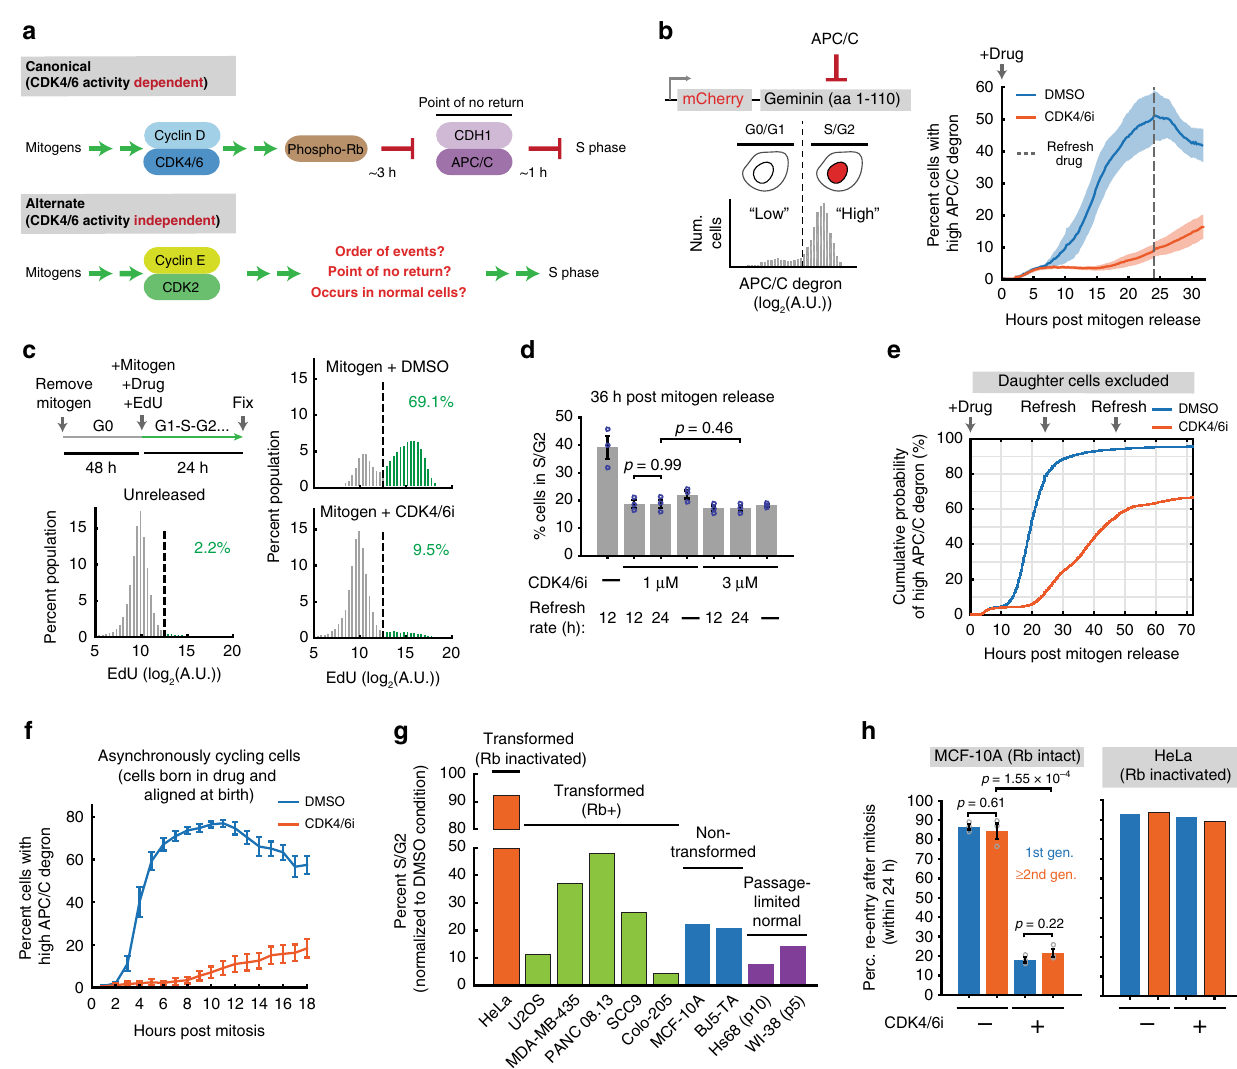
+– Fig. 1 Acute CDK4/6 inhibition reveals a delayed and less ef fi cient cell-cycle entry mechanism. a Two mechanisms of starting the cell cycle. b Left: Degron-based APC/C activity reporter. Right: Mitogen-starved MCF-10A cells expressing the APC/C activity reporter were imaged at the time of mitogen and 1 µ M Palbociclib (CDK4/6 inhibitor) addition. Time points taken every 12 min. CDK4/6 inhibitor refreshed at 24 h. Mean± SEM from fi ve biological replicates. Vertical gray dashed line: time of refreshing drug. c MCF-10A cells mitogen released in the presence of EdU with or without CDK4/6 inhibitor. Cells were fi xed after 24 h (26838, 36549, 29371 cells for unreleased, DMSO, and CDK4/6 inhibitor; 1 of n = 2 biological replicates). d Cells were mitogen released with or without indicated CDK4/6 inhibitor concentrations and the drug was refreshed every 12 h, 24 h, or not at all. Cells fi xed at 36 h after mitogen release. S/G2 cells determined via EdU incorporation and DNA content. Mean ± SEM from three biological replicates; p values calculated using two-sided, two-sample t tests. e CDF of mitogen-released cells inactivating APC/C CDH1 . Only cells present at the time of mitogen release are tracked. n = 7521 and 9563 cells for DMSO and CDK4/6i, respectively. f Percent cells with inactivated APC/C in cells born into DMSO or CDK4/6 inhibitor. Cells aligned at birth. Mean± SEM from fi ve biological replicates. g Different cell lines treated with 1 µ M CDK4/6 inhibitor for 48 h and refreshed at 24 h. Percent S/G2 de fi ned as >2 n DNA (determined by Hoechst) and high endogenous geminin (an APC/C CDH1 substrate). Percentages normalized to the DMSO- treated condition. h Generation comparison of cell-cycle re-entry percentages in MCF-10A (Rb intact) and HeLa (Rb inactivated) cells (MCF10A: mean ± SEM from three biological replicates; p values calculated using two-sided, two-sample t when cells enter mitosis. Starting live-cell imaging at the time of CDK activity in most cells increased in a persistent and linear mitogen release to determine the cyclin E/A-CDK activity base- fashion (Fig. 2b, left). An analysis of thousands of individual cells line, we found that a portion of CDK4/6 inhibitor-treated cells showed that CDK4/6-inhibited cells built up cyclin E/A-CDK indeed upregulated cyclin E-CDK2 activity after variable delays activity slower (Fig. 2b, blue cells) and some cells had fl uctuating (Fig. 2b, blue cells, which is de fi ned as >0.7 on the last time point; activities (green cells, de fi ned as <0.7 at 24 h, but >0.7 at least 0.7 threshold marked with horizontal gray dashed line and once between 8 and 24 h). The increasing trend of fl uctuating determined based on time 0, when no CDK activity is present). cells in CDK4/6-inhibited cells is not due to threshold selection As expected, activation of cyclin E-CDK2 was delayed in CDK4/ (Supplementary Fig. 2b). Further control experiments with a 6-inhibited cells (Supplementary Fig. 2a), but surprisingly, the DHB mutant that cannot translocate showed that most fl uctua- kinetics were distinct from that of control cells, where cyclin E/A- tions were not measurement noise, and that the fl uctuating cells